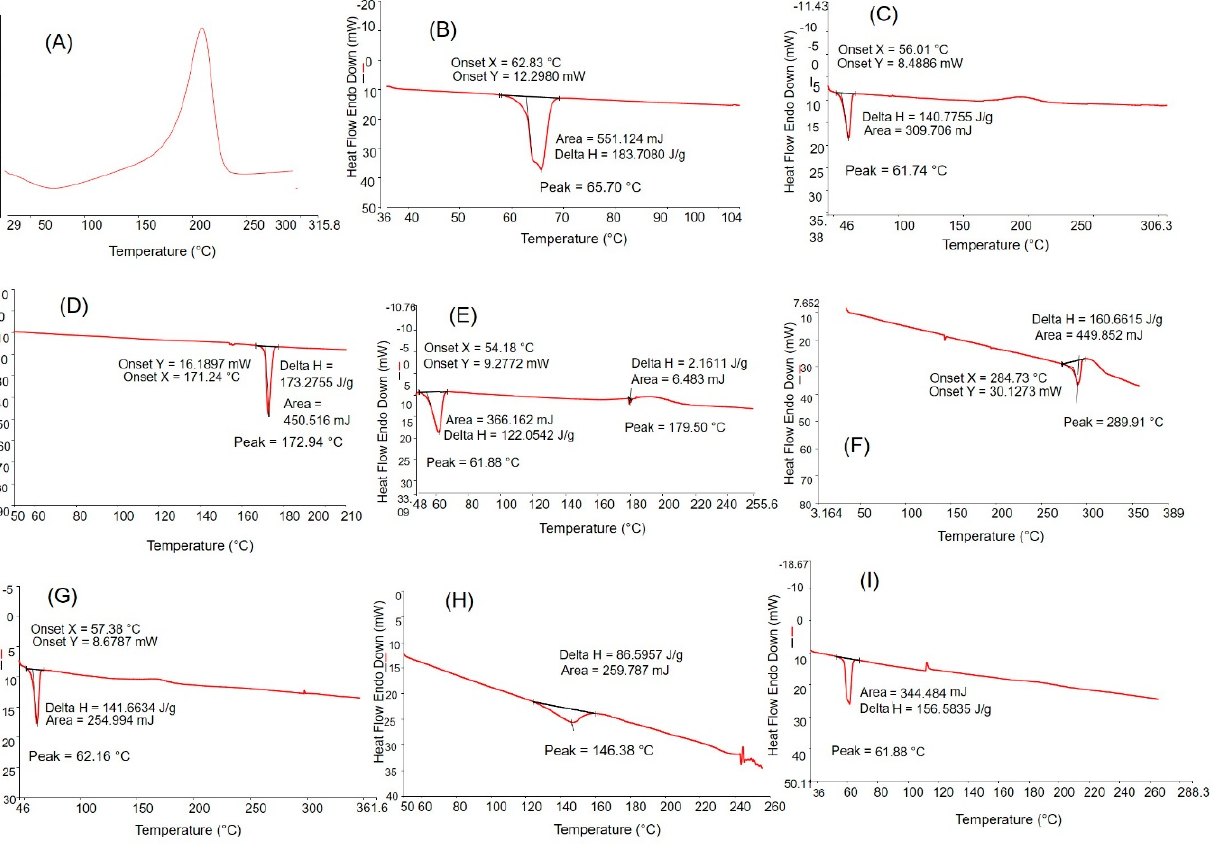
Figure 6. DSC thermograms of ( A ) NGO, ( B ) PEG 6000, ( C ) NGO-PEG, ( D ) AMP, ( E ) AMP loaded NGO-PEG, ( F ) DIC, ( G ) DIC-loaded NGO-PEG, ( H ) MTX, and ( I ) MTX-loaded NGO-PEG.